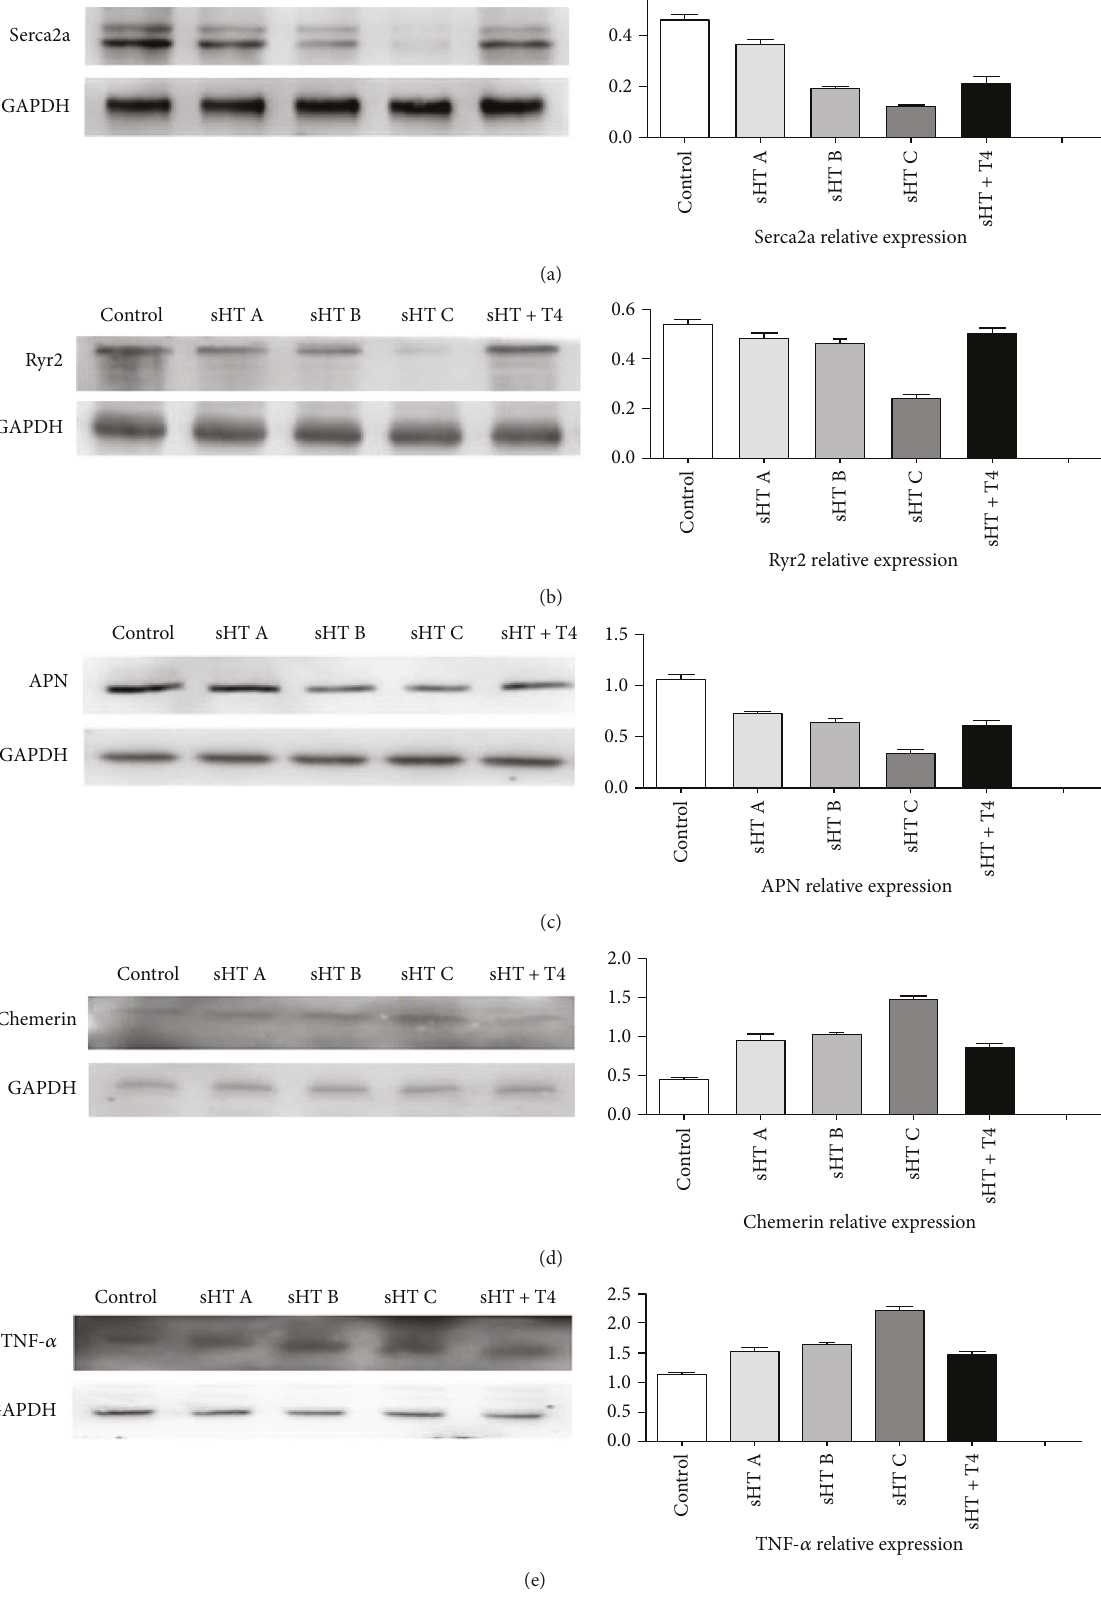
Figure 3: The protein expression of serca2a, Ryr2, APN, chemerin, and TNF- α in the cardiac muscle tissue was measured with Western